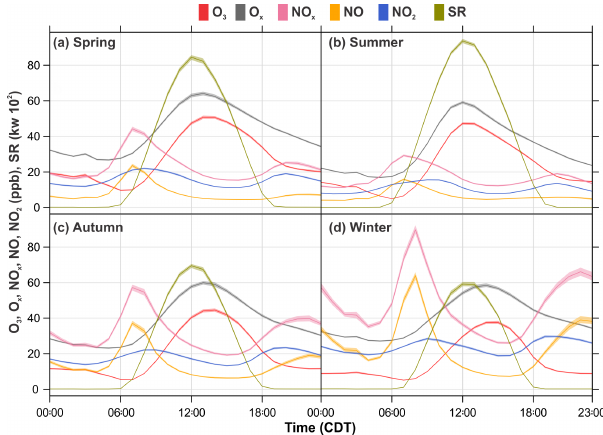
Figure 3. Seasonal average daily profiles for O 3 , O x , NO x , NO, NO 2 , and SR within the MMA during 1993–2014. The shading shows the 95% confidence intervals of the average.